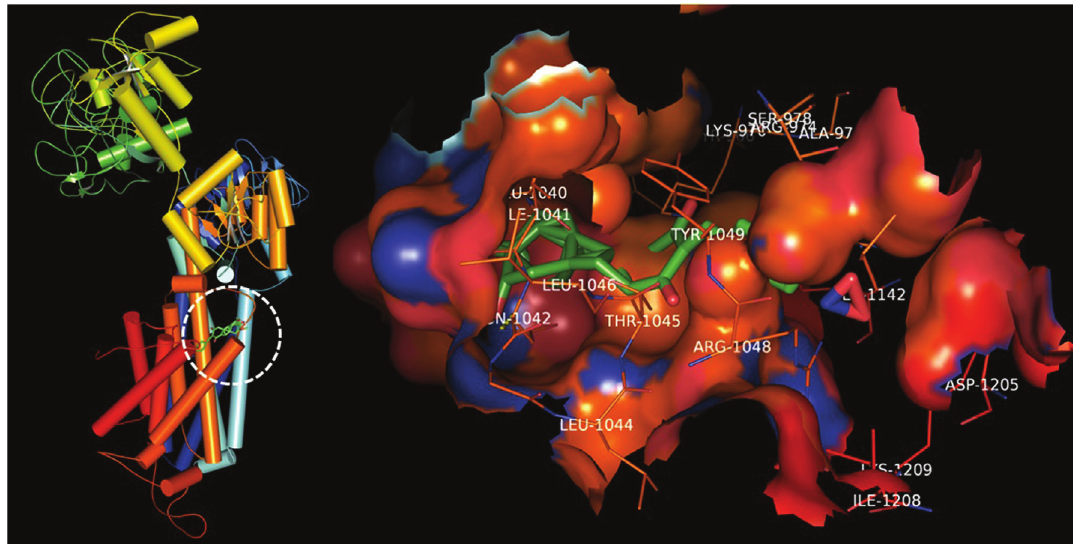
FIGURE 4 - Artemisin docked